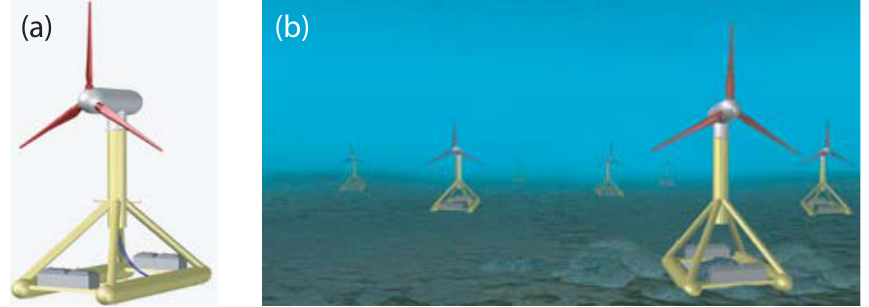
Figure 6. ( a ) Proposed TEC; ( b ) view of proposed tidal